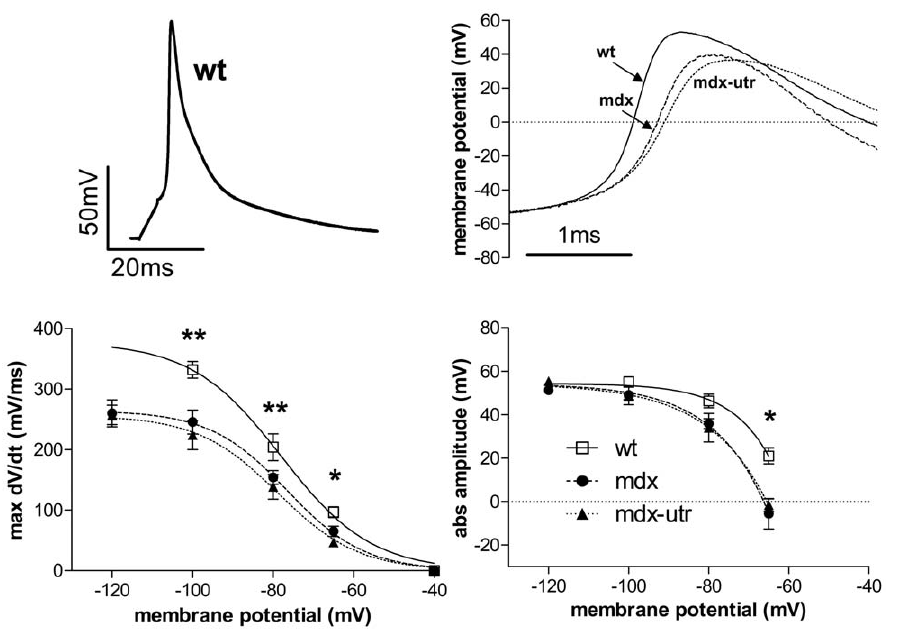
Figure 4. Action potential properties in wt and dystrophic adult cardiomyocytes. Typical AP of a wt cardiomyocyte (top left) elicited by a 4-ms current injection at 125% threshold. On the top right, the upstrokes of typical APs recorded from wt and dystrophic cardiomyocytes are overlayed on an expanded time scale. In the lower panel, maximum upstroke velocity (max. dV/dt), and the maximum depolarisation value reached by the AP (abs. amplitude) are plotted against the membrane potential. * and ** indicate significant differences (ANOVA; p , 0.05 and , 0.01; n-values: 5–8) between the three tested groups, respectively. Tukey’s Post Hoc test revealed no significant differences between mdx-utr and mdx.